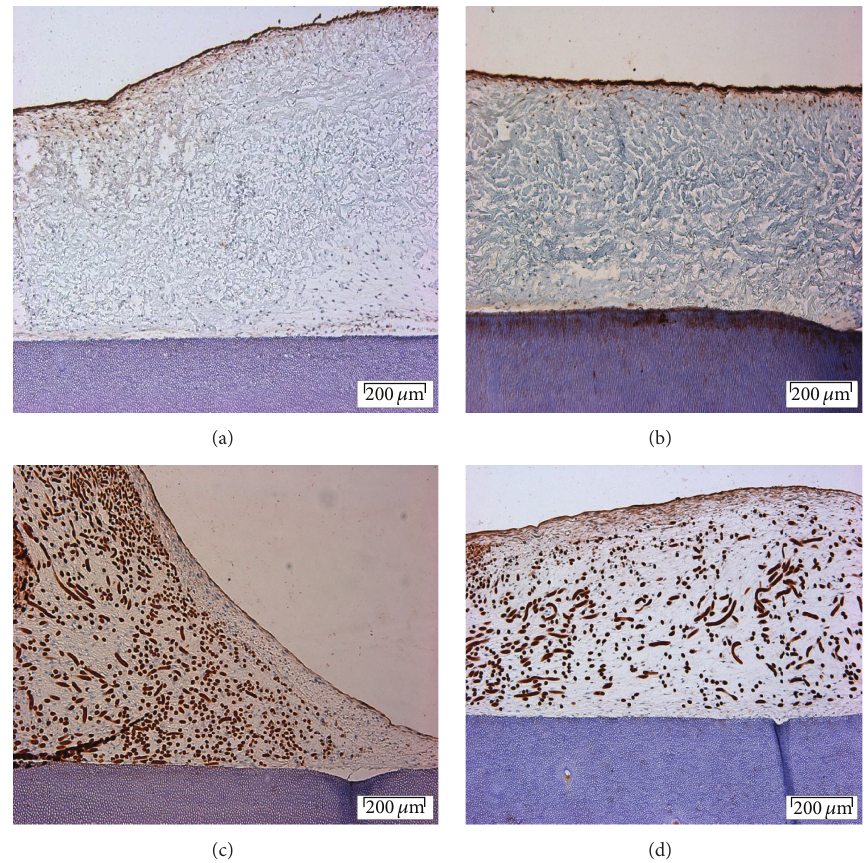
Figure 4: Runx2 expression in (a) collagen-spheroids-dentin, (b) collagen monolayer fibroblast-dentin, (c) PGA-spheroid-dentin, and (d) PGA-monolayer fibroblast-dentin complex cultures after 20 days. Original magnification × 10 (scale bar = 200 𝜇